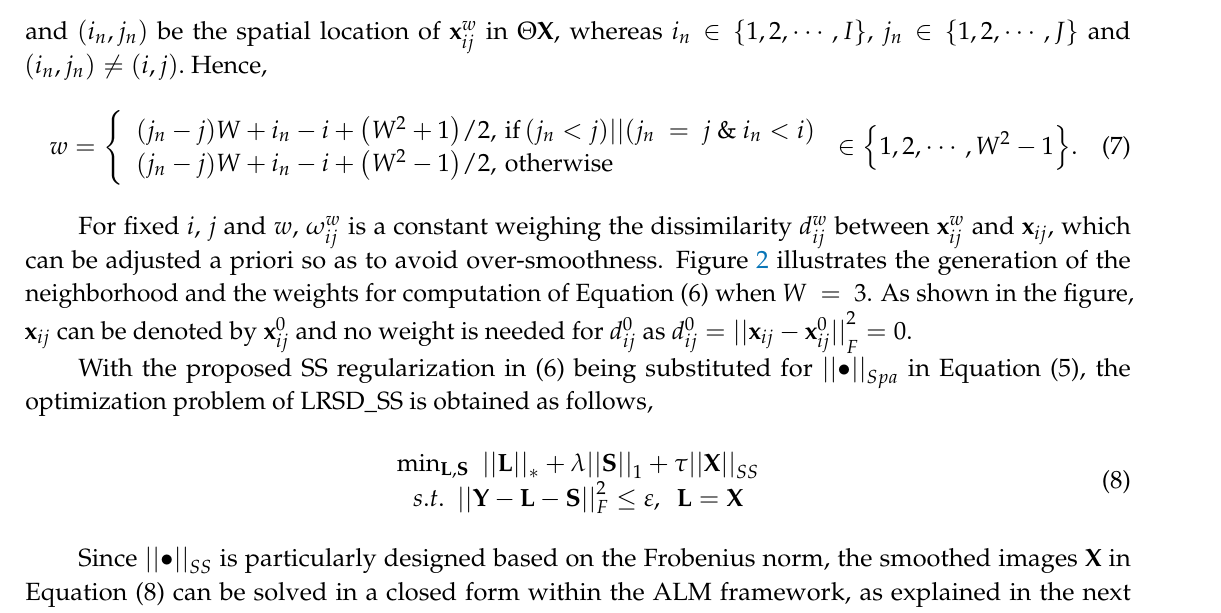
d , whereas , whereas ij ij